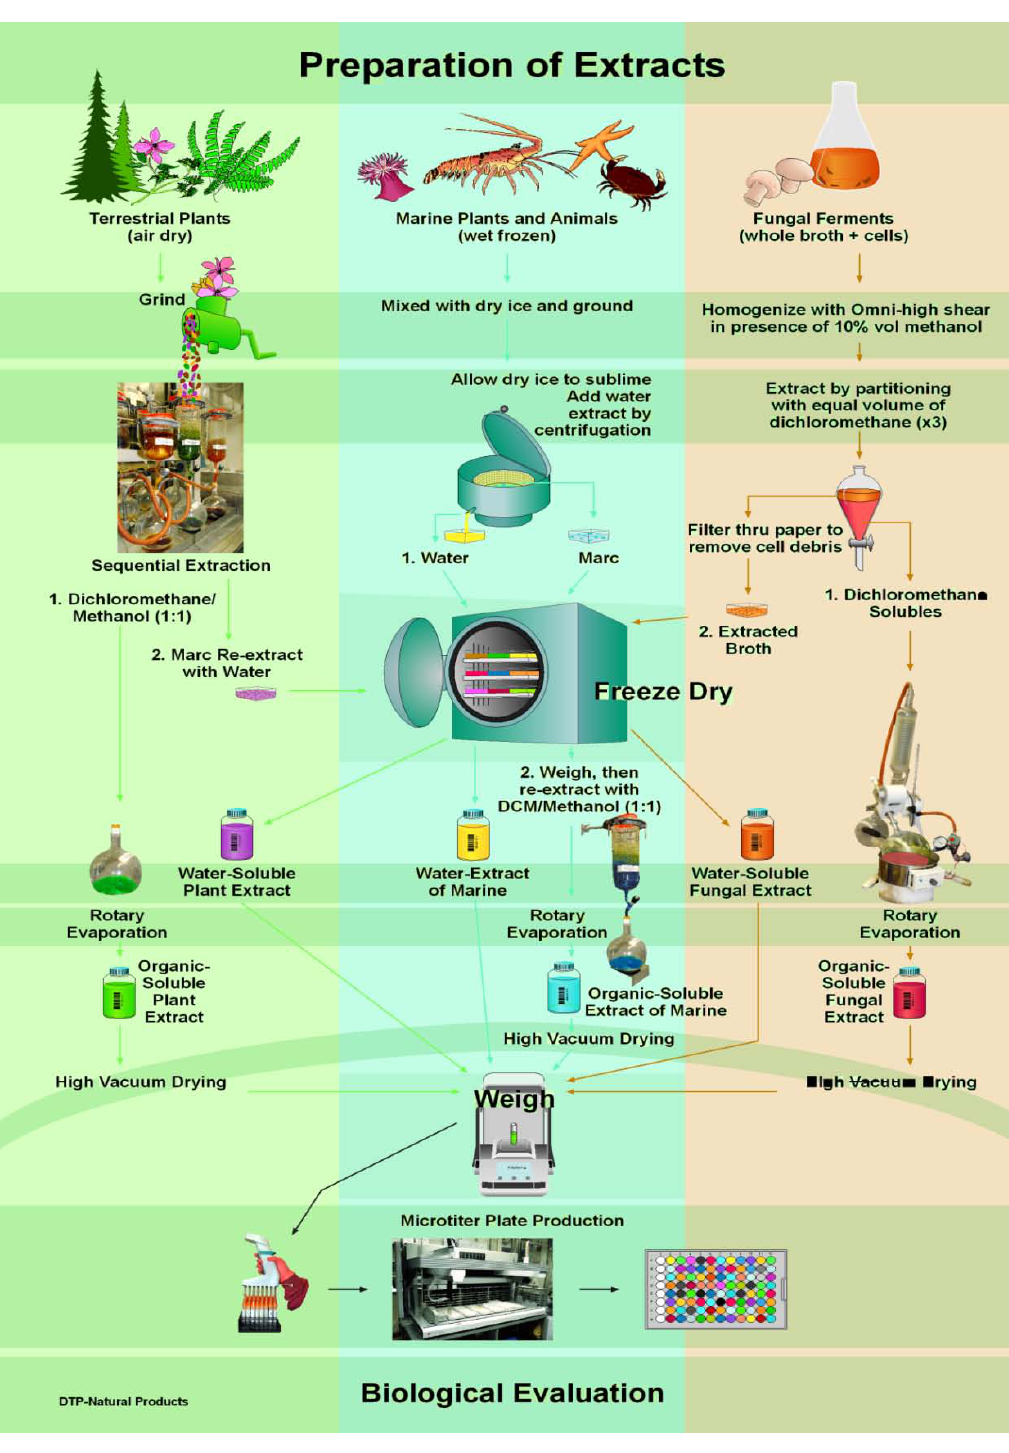
Figure 2. Flow Scheme for Production of Higher Plant, Marine Organism, and Microbial Extracts for Biological Testing at